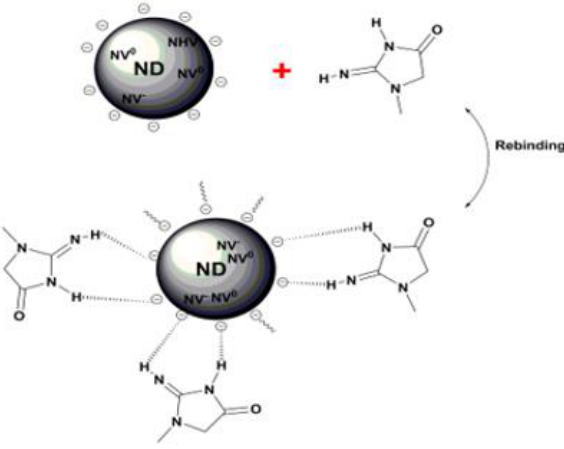
Figure 7. Schematic showing Coulomb interaction between nanodiamonds and creatinine molecules where charge state of near-surface nitrogen-vacancy centers can be affected.